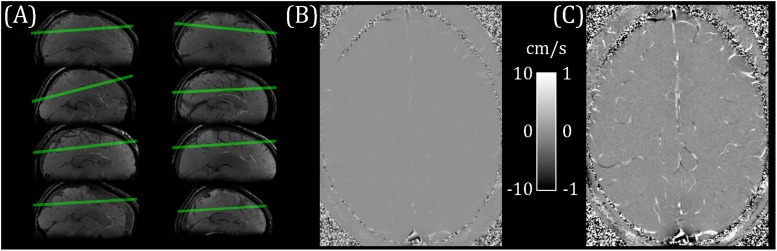
(A) pcMRI slice positioning for each subject (overlaid on a sagittal cut-through of the whole-brain T2*-weighted localizer image). (B) Example flow velocity map (mean across cardiac cycle). (C) Windowed version of B, ranging from −1 to + 1 cm/s.